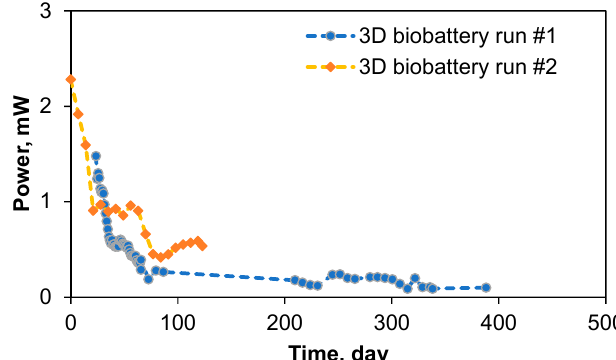
Figure 6. Experimentally measured power outputs of the biobattery for 388 days (run #1) and 123 days (run #2). Power outputs during temperature, salinity, and carbon source tests (day 100–210) are excluded for run #1.